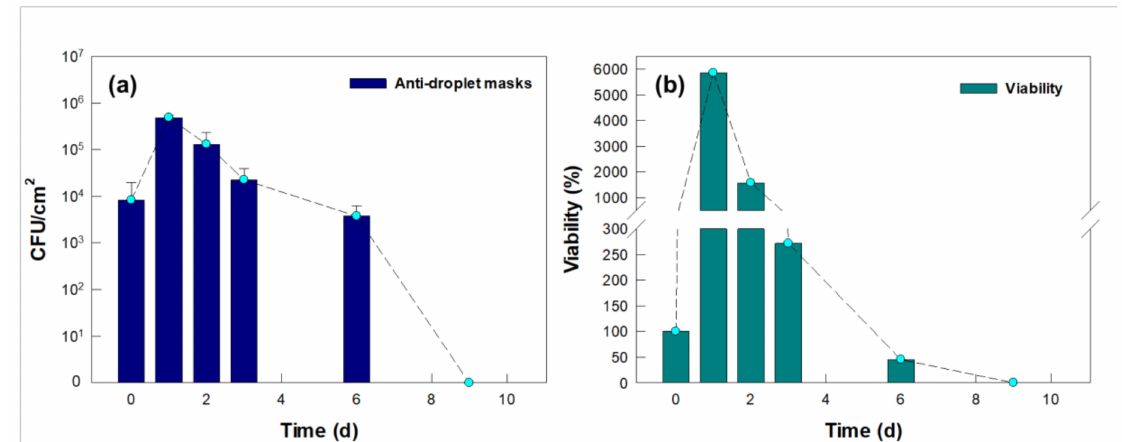
Figure 3. Viability levels of B. subtilis from airborne bioaerosols filtered by an anti-droplet face mask. ( a ) Colony forming unit (CFU)/cm 2 values and ( b ) viability rates of the B. subtilis airborne bioaerosols. Error bars represent standard deviation of the data ( n = 9). The dashed line shows a trend of each